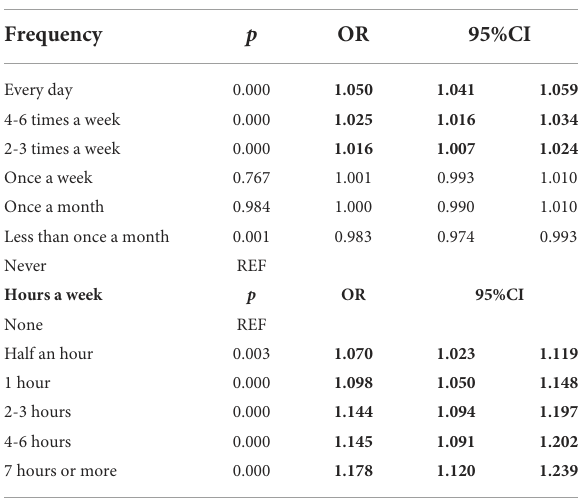
TABLE 1 Association between vigorous physical activity and life